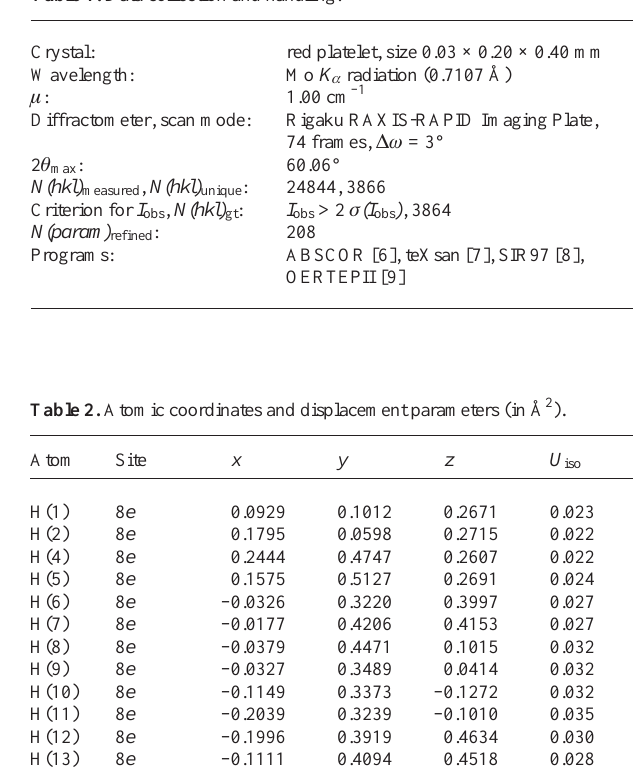
Table 1. Data collection and handling.